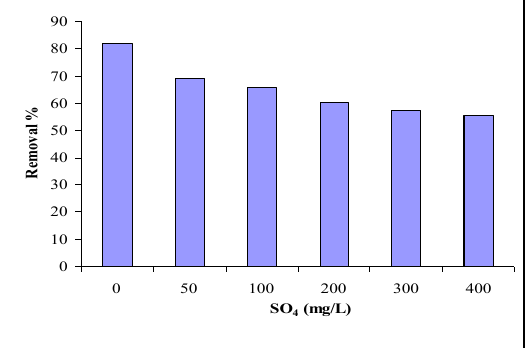
Figure 1 . Comparison of removal percentage for degradation of malathion in the presence of sulfate pH=9; Time=180 S;H